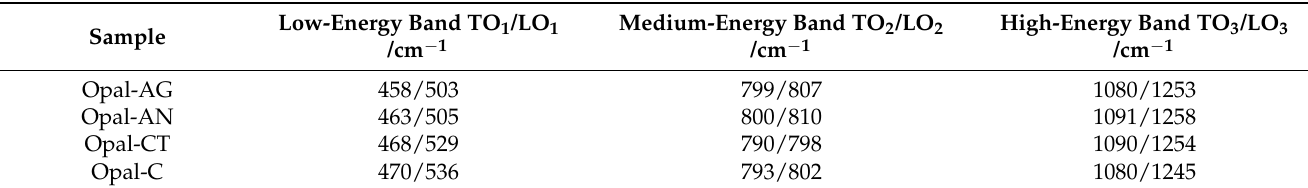
Table 5. TO and LO band peak positions taken as the maxima in the Im{ ε } and Im{ − 1/ ε } spectra that were derived from the Kramers-Kronig transform of 15 ◦ incidence angle reflection spectra for samples displayed in Figure 6.